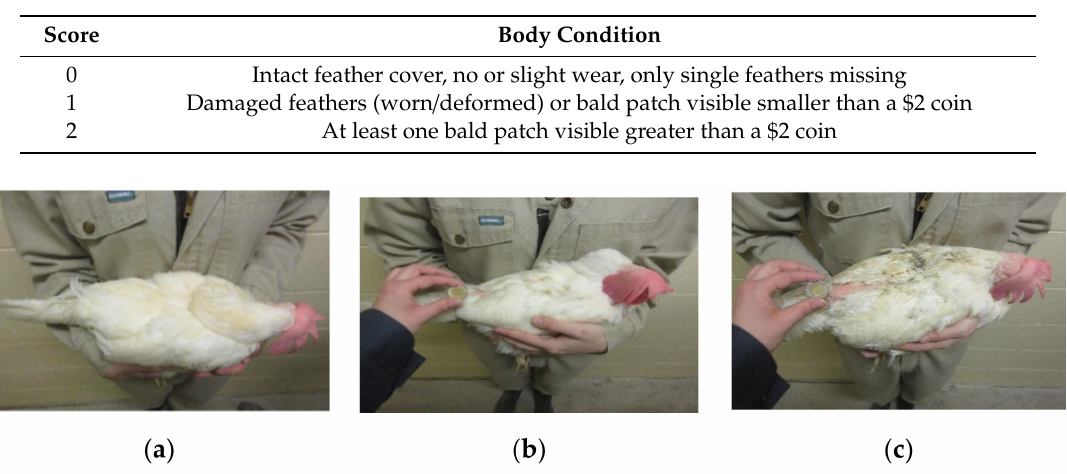
Table 5. The scoring system used by farmers on site to evaluate the feather condition and amount of feather damage present in their flock. Body areas scored were limited to the back / rump on a sample of 50 birds per